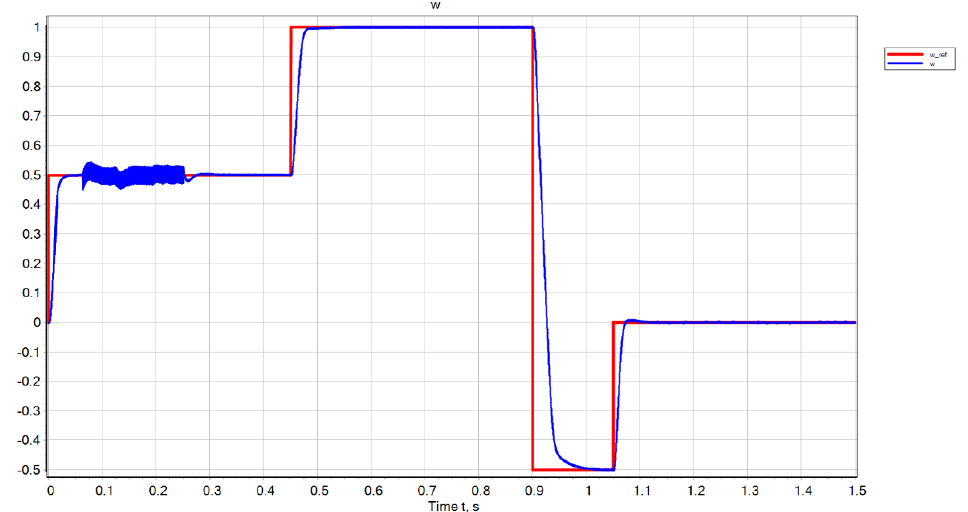
Figure 4. Set angular velocity and angular velocity of the motor at a load moment of inertia of 0.7 kg ∙ m 2 .